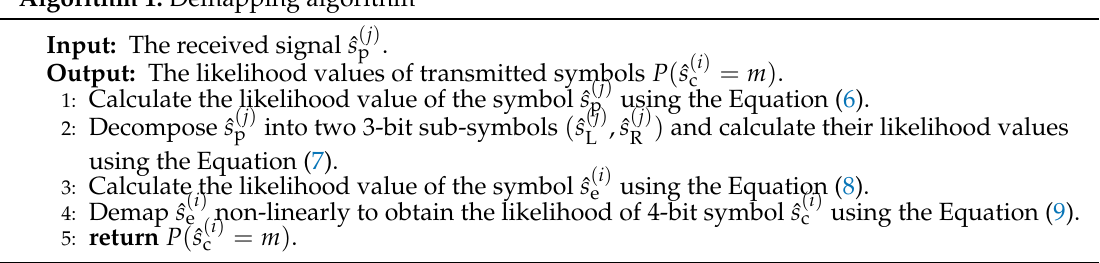
Algorithm 1: Demapping